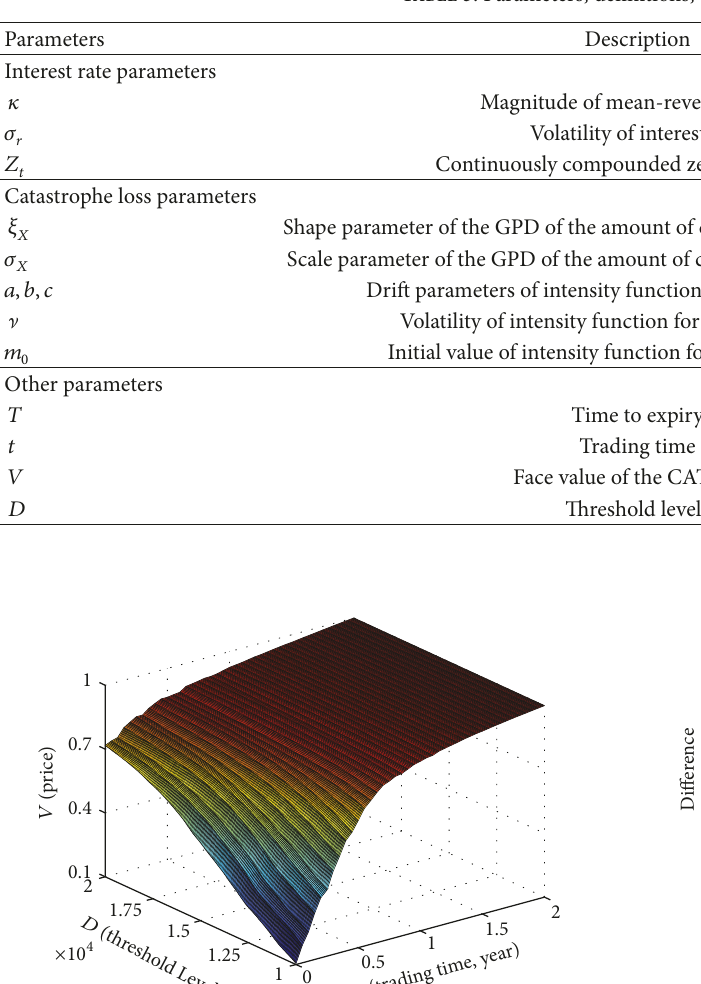
Table 3: Parameters, definitions, and base values.